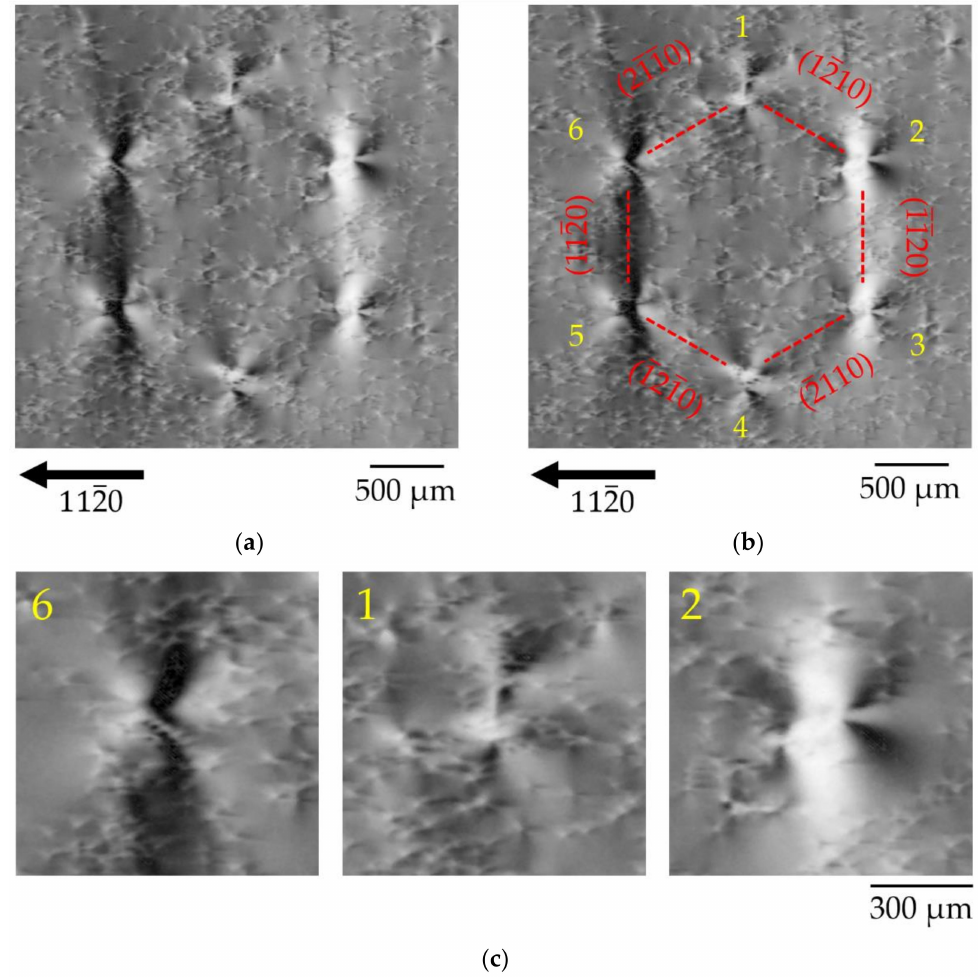
Figure 3. The HCD cluster shown in ( a ) is the enlarged L-XRT image, 1120 reflection, of the one labeled HCD-A on Figure 2b; ( b ) for a better understanding of the explanations in the text, the contrast rosettes were numbered (1 to 6) and the crystallographic planes are indicated; ( c ) details of some of the corners of the hexagon are